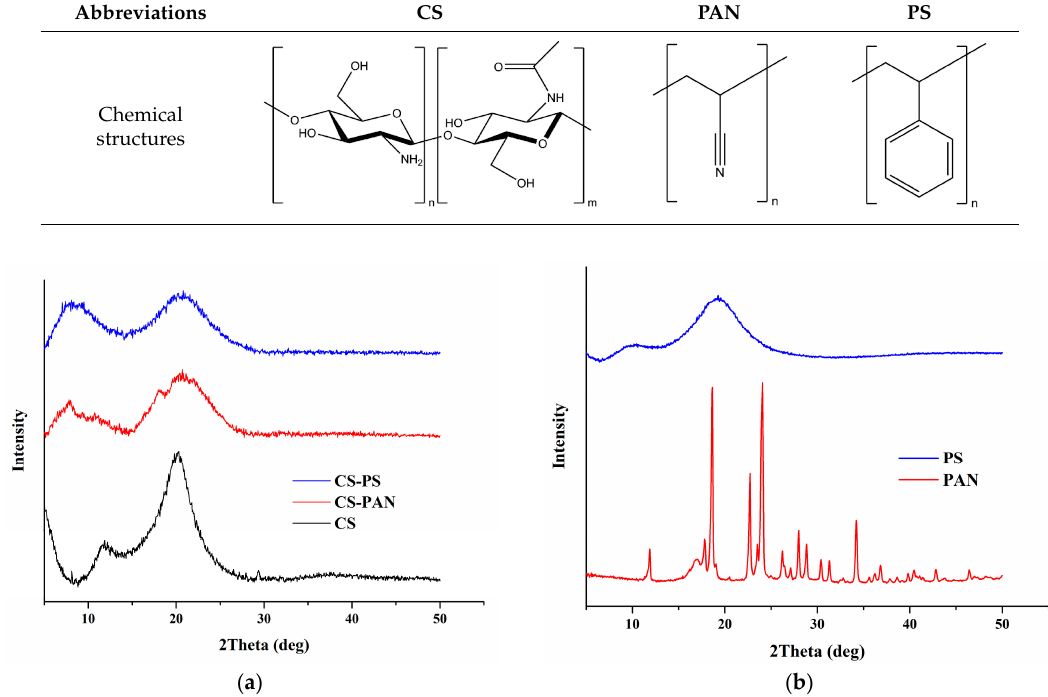
Table 1. Chemical structures and abbreviations of the substances, composing copolymers.